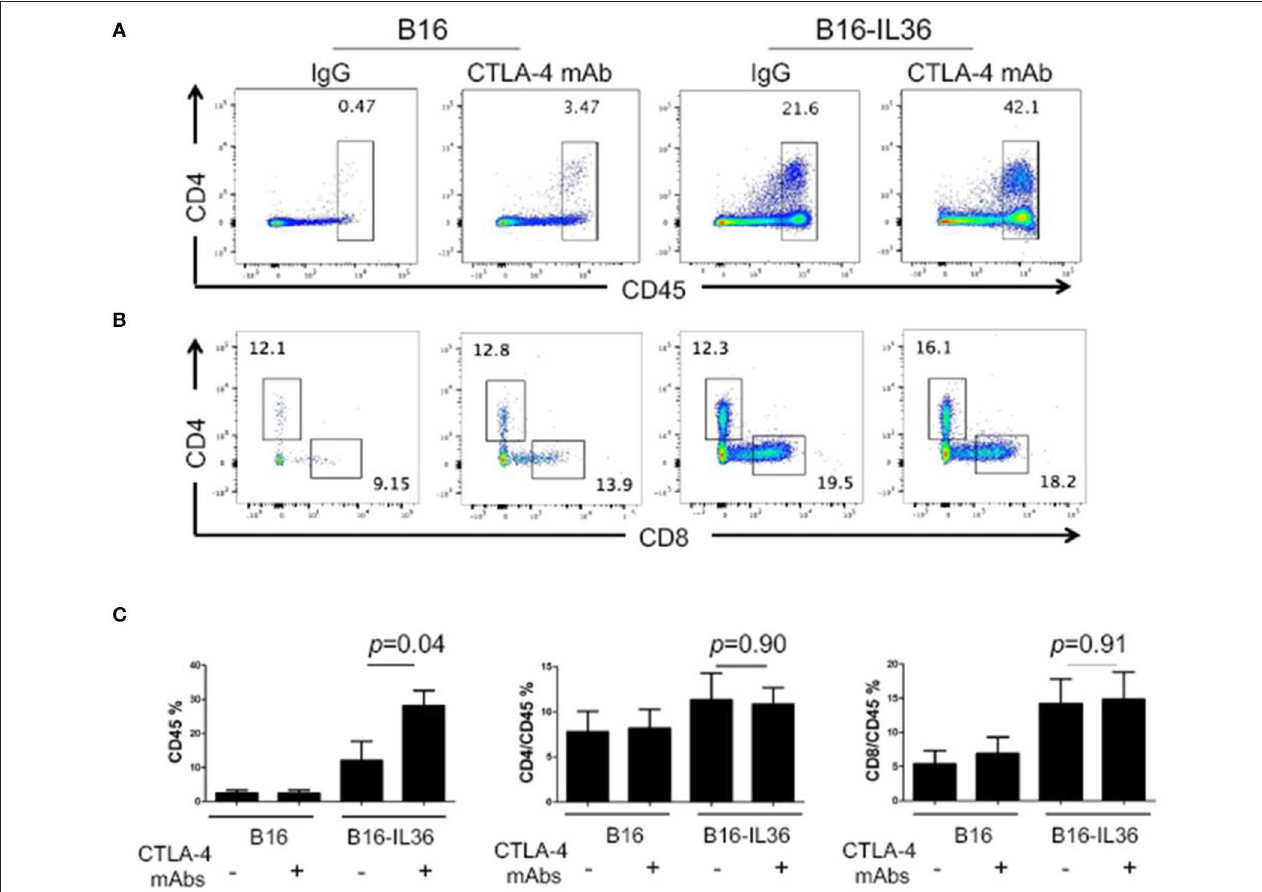
FIGURE 5 | Combination of tumoral expression of IL-36 and anti-CTLA-4 mAbs additively enhanced CD45 + immune cell infiltration in the tumor microenvironment. C57BL/6 mice were injected i.d. with 10 4 B16 or B16-IL-36 cells and were subsequently treated with CTLA-4 or control mAbs ( n = 3 mice/group). Tumors were resected after treatment and subjected to flow cytometry analysis. Representative flow cytometric plots showed CD45 + cells (A,C) , CD4 + T and CD8 + T cells (B,C) in tumor. Results are mean ± SEM of 3 independent experiments.